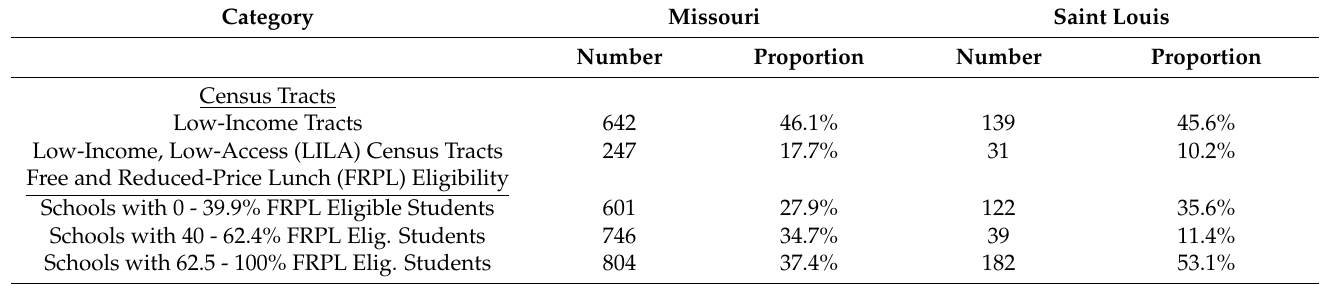
Table 1. Overview of free and reduced-price school meal eligibility in St. Louis, Missouri.